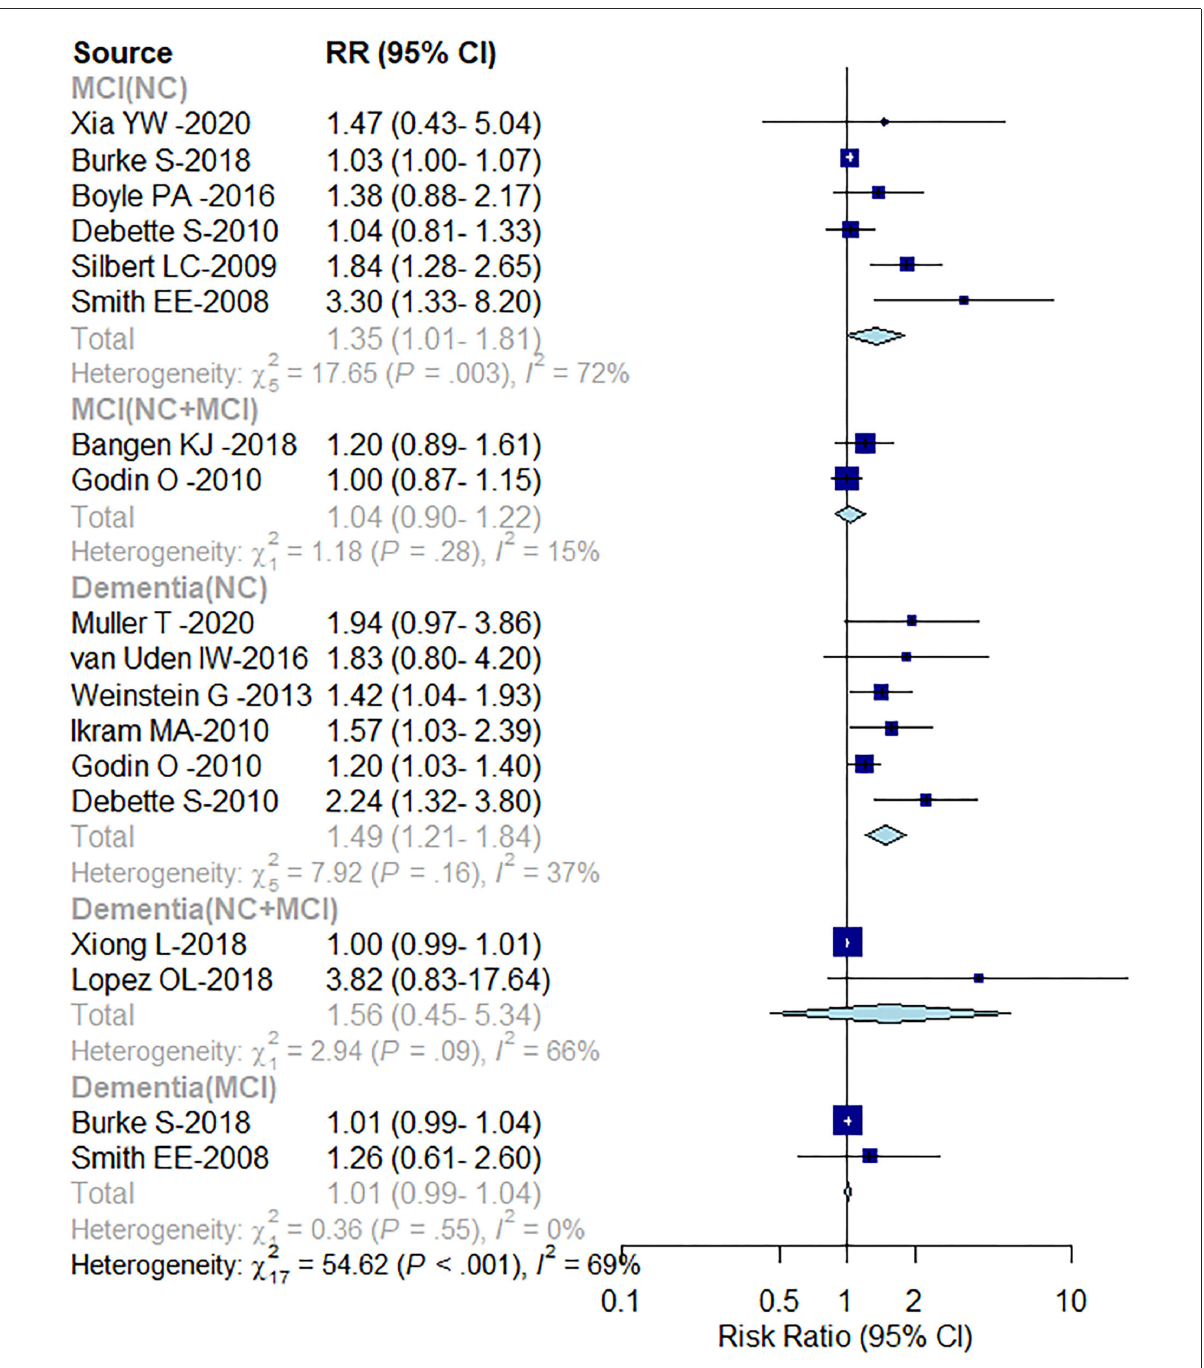
FIGURE3 Subgroup analysis based on cognitive level.